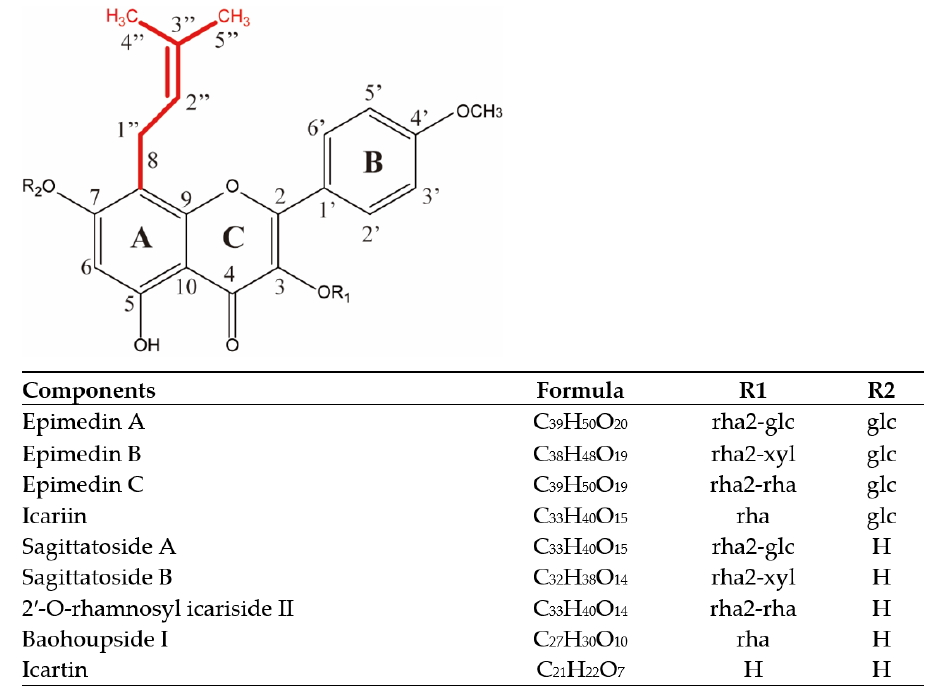
Figure 1. Structures of main isopentenyl flavonols found in Epimedium. Table 2. List of main isopentenyl flavonols and their MRM parameters, from UHPLC-QqQ-MS/MS.